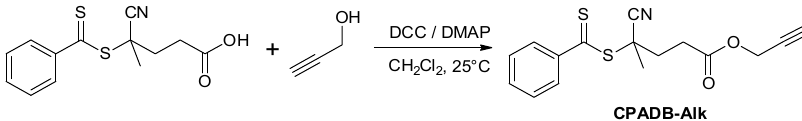
Figure 1. The peak at 4.7 ppm (d,-C(O)-O-C H 2 ) indicates in particular the success of the reaction.